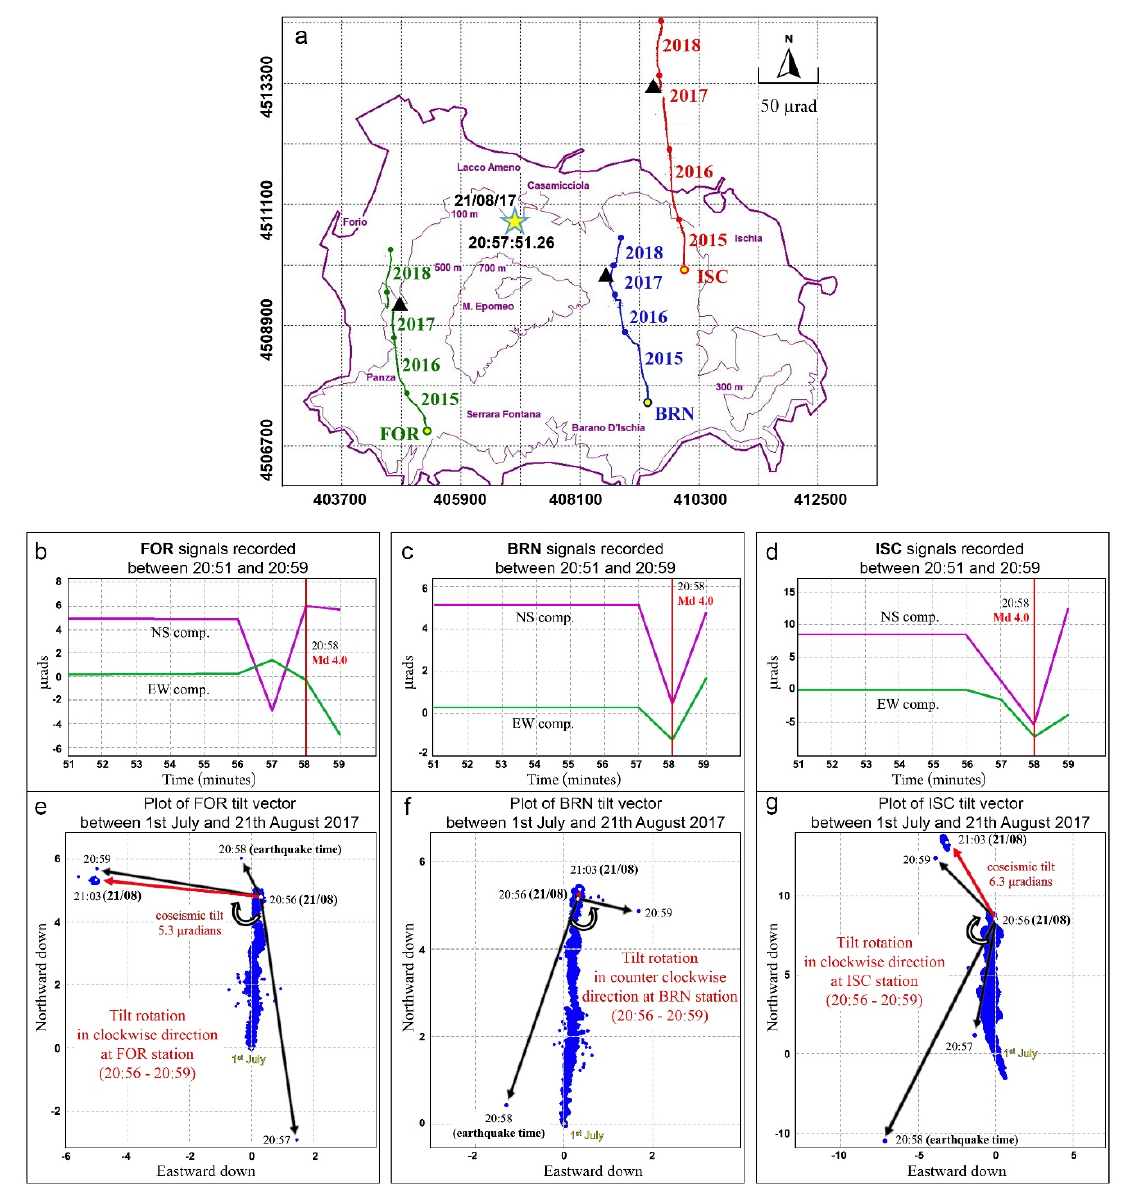
Figure 10. ( a ) Schematic map of Ischia Island, superimposed on a grid representing the two-dimensional plane of ground inclinations, in which each mesh is equivalent to a tilt variation of 50 µ radians. The three sites ISC, FOR and BRN are distinguished by di ff erent colors (red, green and blue, respectively). The hodographs observed at each site in the time span 1 June 2015–31 December 2018 show a well-defined polarization towards the NNW but with a greater inclination in the northeastern sector. (The epicenter of the EQ2017 is marked with a yellow star). ( b – d ) NS and EW components of the tilt signals observed at FOR, BRN and ISC in the time interval 20:51–20:59 (red vertical lines mark the EQ2017). ( e – g ) Plots of the tilt vectors recorded at FOR, BRN and ISC between 1 July 2017 and 21 August 2017. The red arrows indicate the permanent coseismic o ff set and the black arrows indicate the tilt direction observed during the EQ2017.